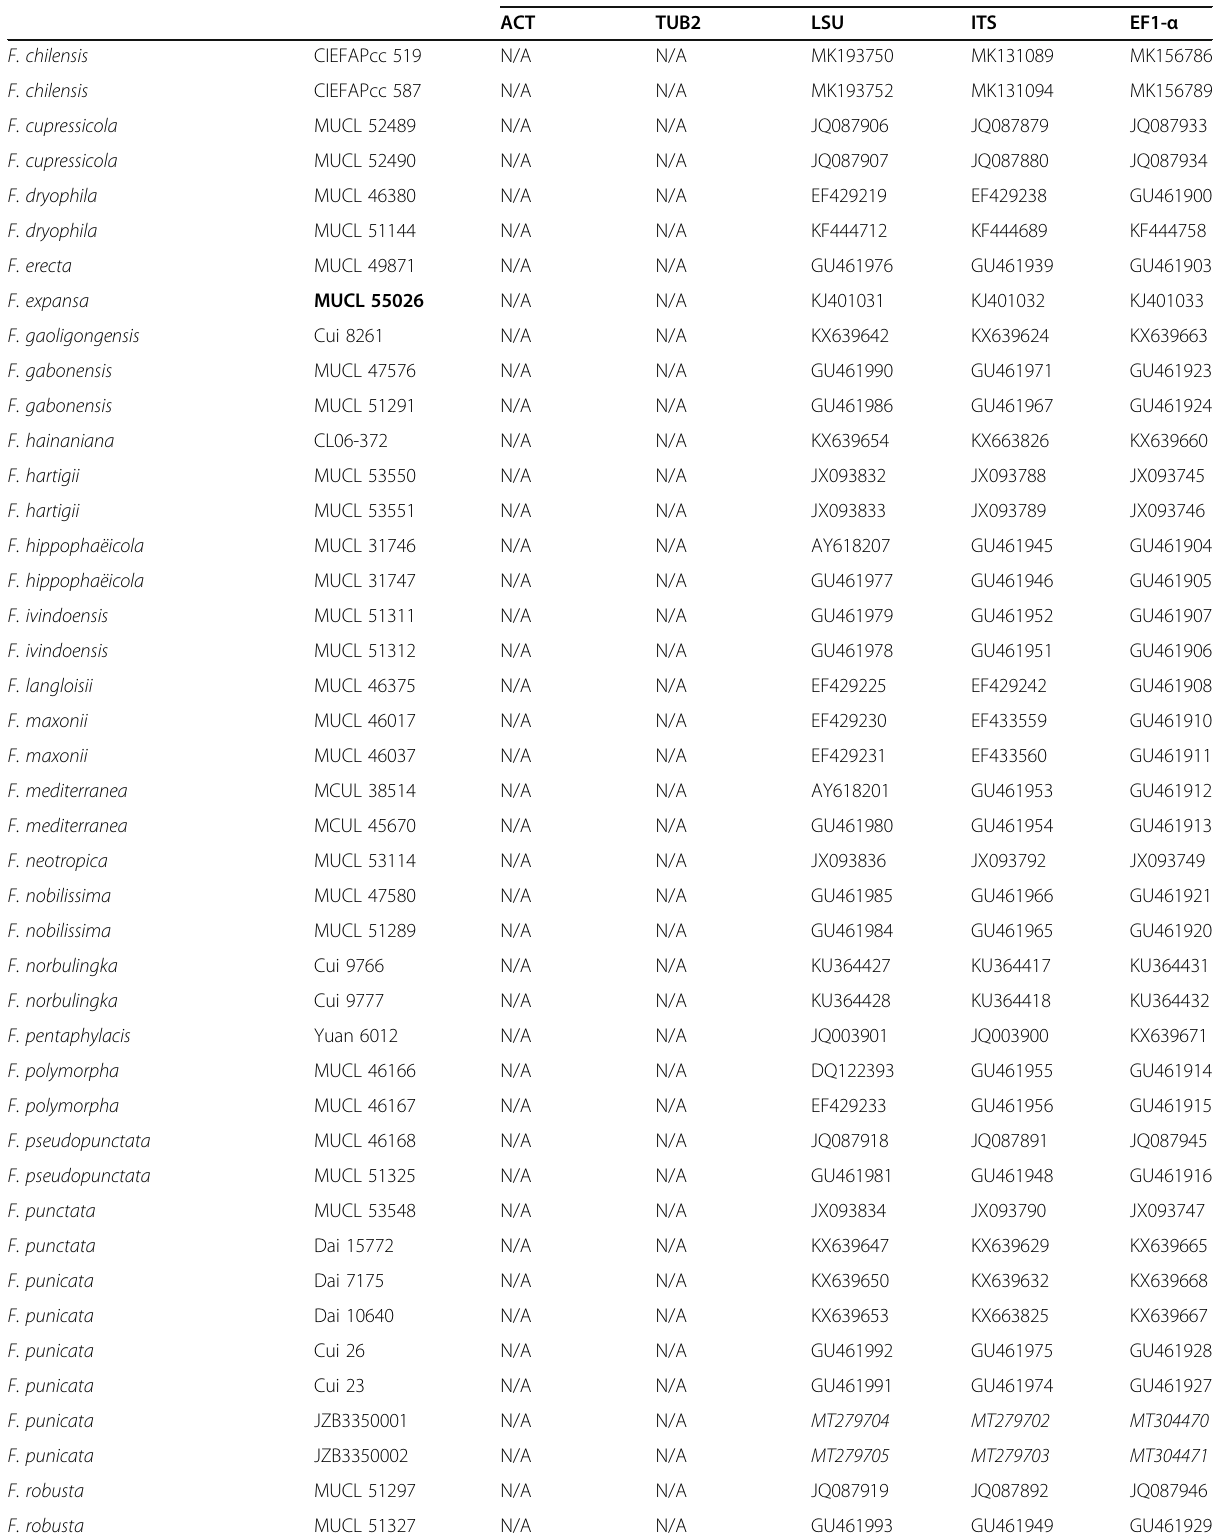
Table 2 Isolates and GenBank accession numbers of Phaeoacremonium and Fomitiporia species in this study (Continued)